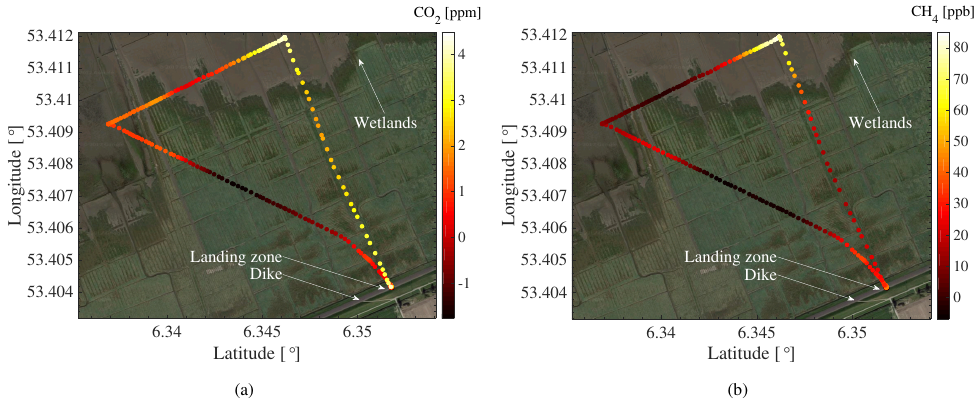
Figure 12. The measured mole fractions of CH 4 and CO 2 during the fourth flight. Takeoff for the flight was on the dike, flying out towards the sea, doing a 90 ◦ turn, and flying along the coast before heading back to the takeoff spot. The white/yellow and red/black colors indicate high and low mole fraction enhancement,